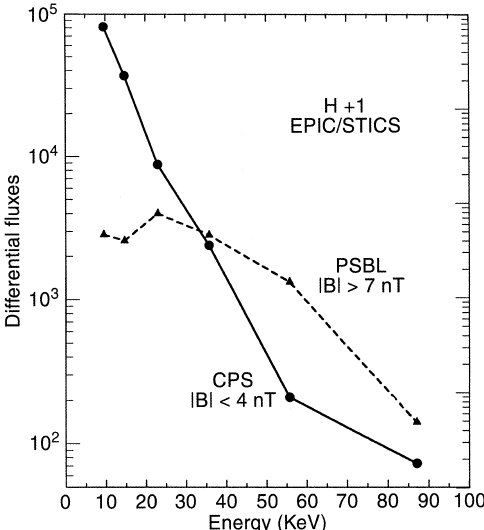
Fig. 3. The central plasma sheet shows a softer spectrum for energetic protons as compared to that at the plasma sheet boundary layer. This figure is derived from data corresponding to the interval 17:05–17:25 UT of